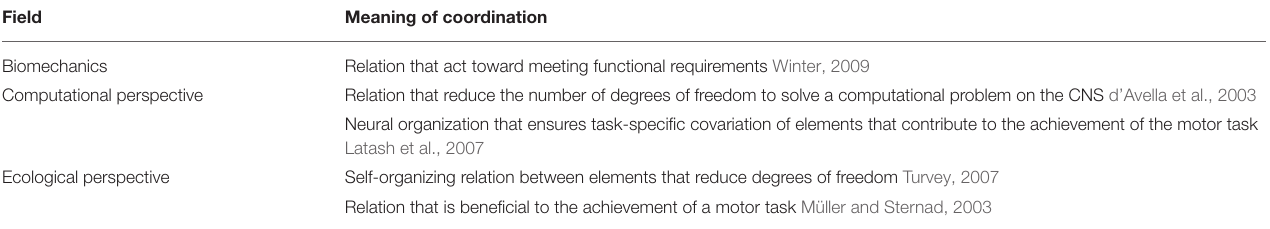
TABLE 1 | Meaning of coordination in each field.